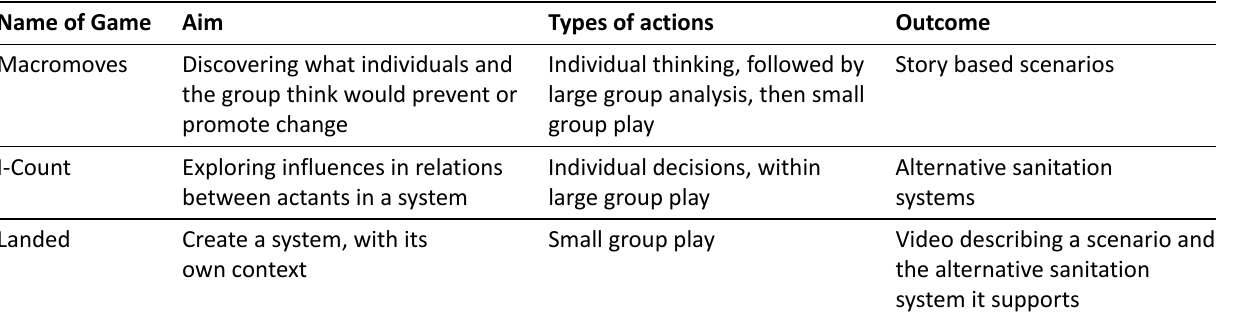
Figure 2. Alternative sanitation exhibition. Photograph by Danielle Willkens. Table 1. Synopsis of games in sequence of